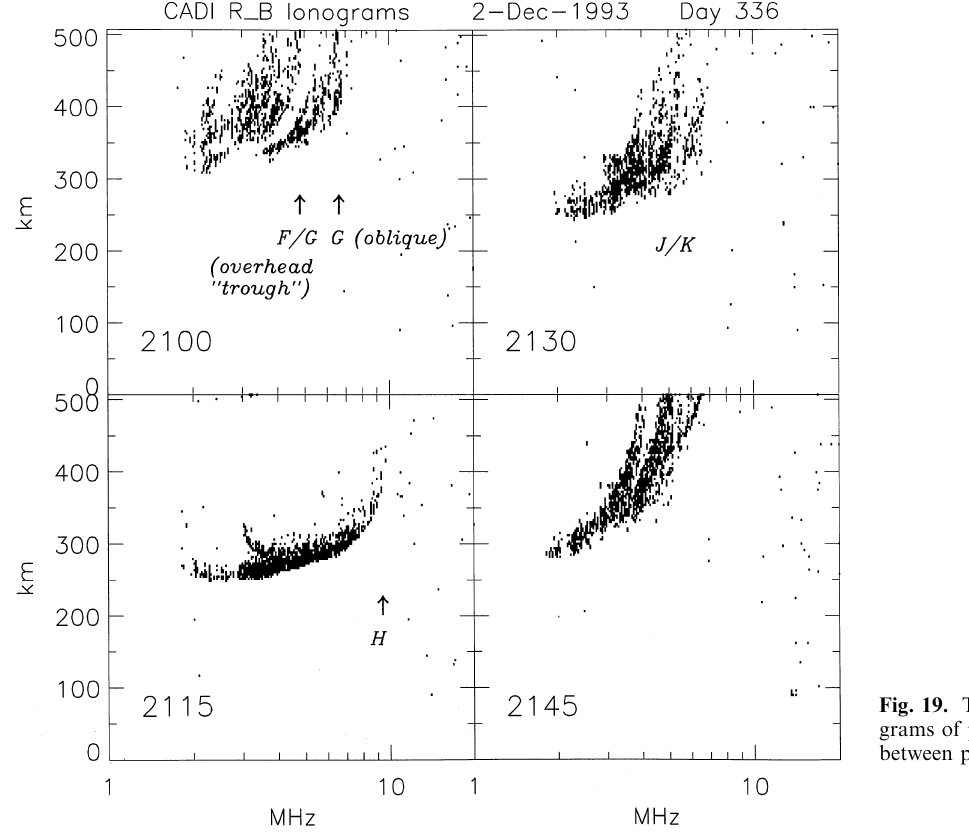
Fig. 19. The Resolute Bay CADI iono- grams of polar cap patches and troughs